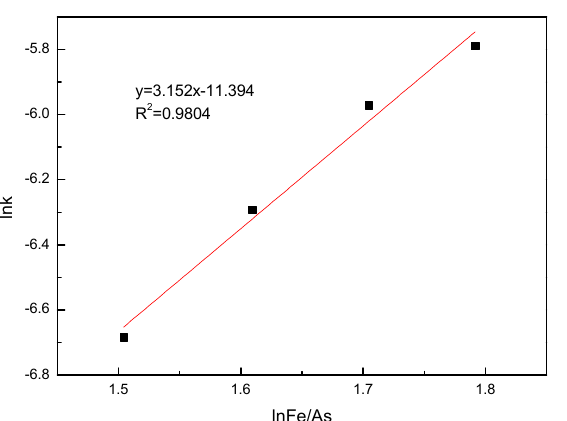
Figure 9. Plot of lnk vs. ln(Fe/As) for the determination of reaction order.